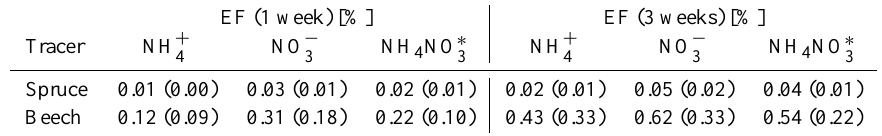
-labelled and NO − -labelled treatments of the short-term experiment ( n = 4). 4 3 EF (1 week) [%]